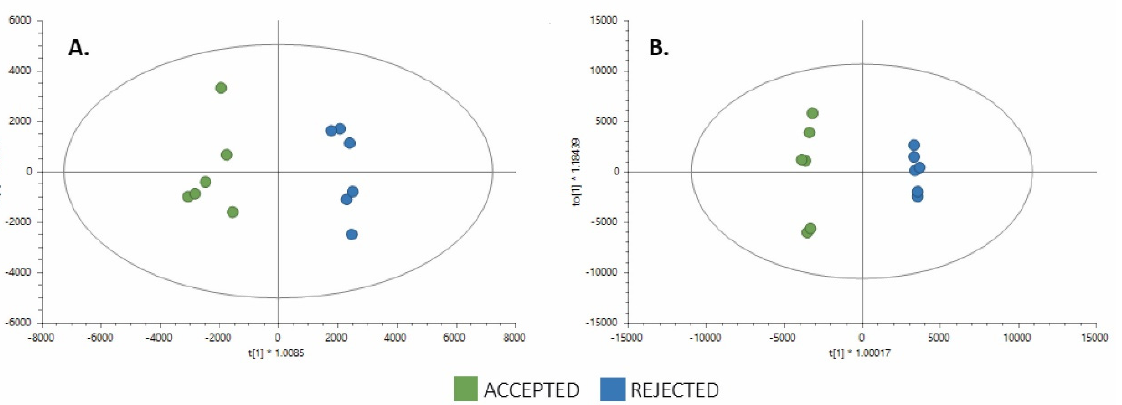
Figure 1. PCA score plots for untargeted metabolomics in both positive and negative ESI modes. (Green dots, accepted samples ( n = 6); blue dots, rejected samples ( n = 6); dark red dots, quality control samples, QC.) ( A ) LC-QTOF-MS (+) with QC samples: R 2(cum) : 0.853, Q 2 (cum) : 0.847. ( B ) LC-QTOF-MS ( − ) with QC samples: R 2(cum) : 0.873, Q 2 (cum) : 0.841. ( C ) LC-QTOF-MS (+): R 2(cum) : 0.629, Q 2 (cum) : 0.386. ( D ) LC-QTOF-MS ( − ) : R 2(cum) : 0.701, Q 2 (cum) : 0.428.